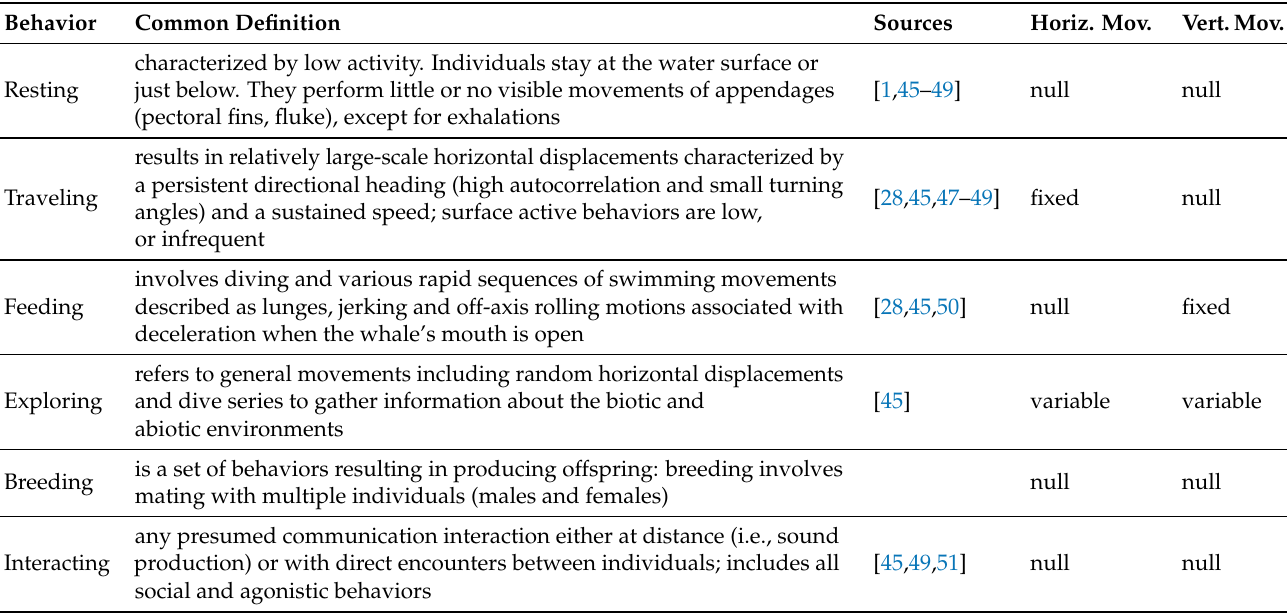
Table 1. Definition of the humpback whale behaviors in the model ethogram. Horiz. Mov. and Vert. Mov. stand for horizontal and vertical movements